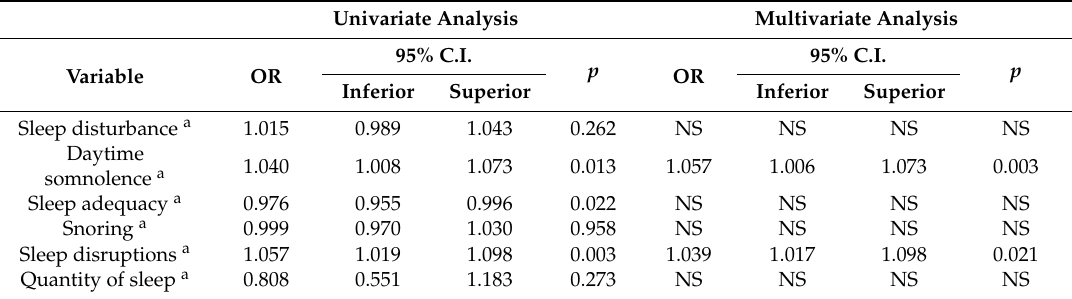
Table 3. Univariate and multivariate logistic regression to analyze the factors related to the presence of migraines. Univariate Analysis Multivariate Analysis